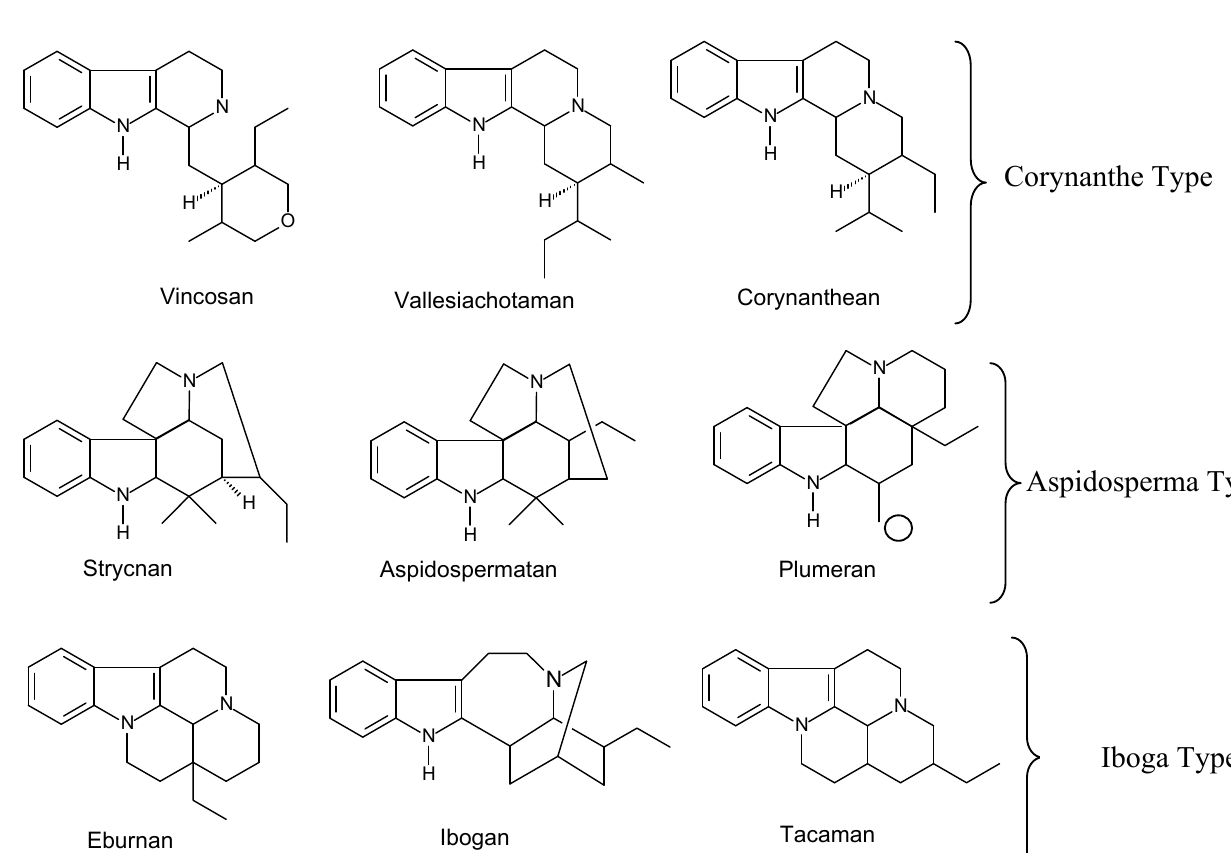
Figure 1. Subclasses of indole alkaloids.